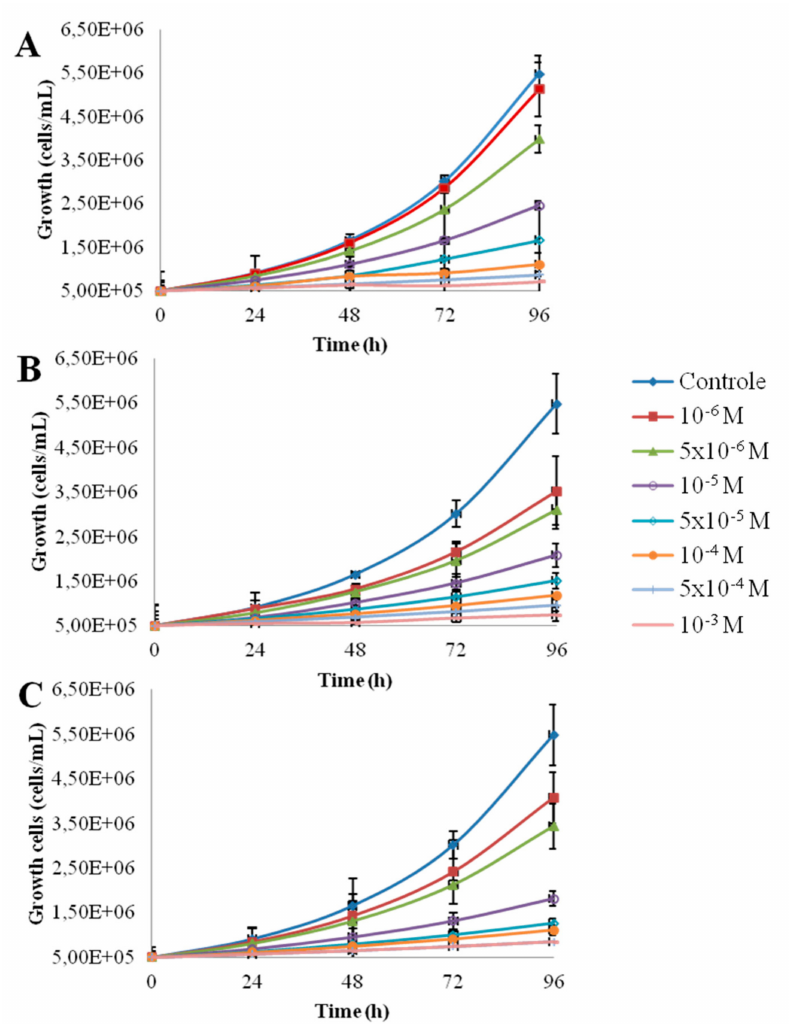
Figure 3. Growth rate of Chlorella vulgaris as a function of time after contact with Cd 2 + free ions and CdS-1 and CdS-2 nanoparticle in Seine river water: ( A ) Cd 2 + , ( B ) CdS-1, ( C )